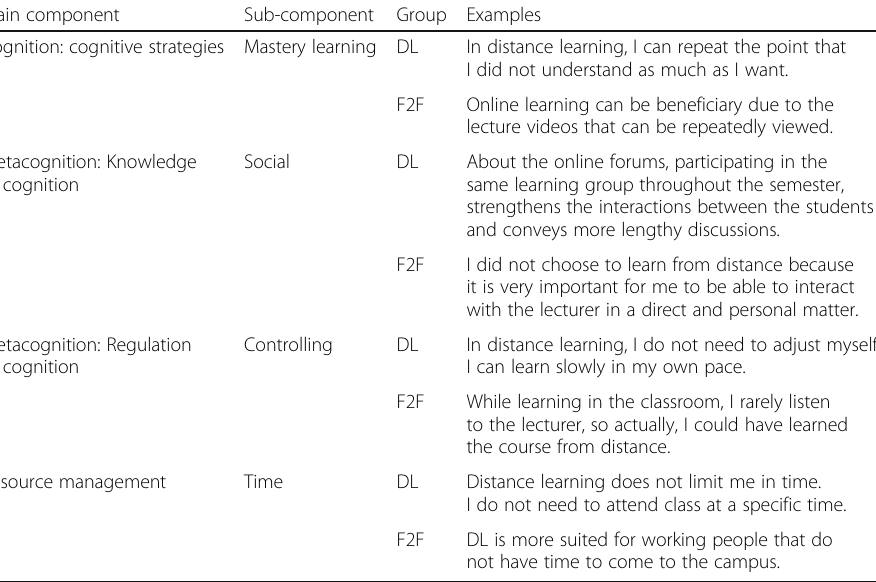
Table 1 Examples of SRL skills identified in students ’ statements about their learning process Main